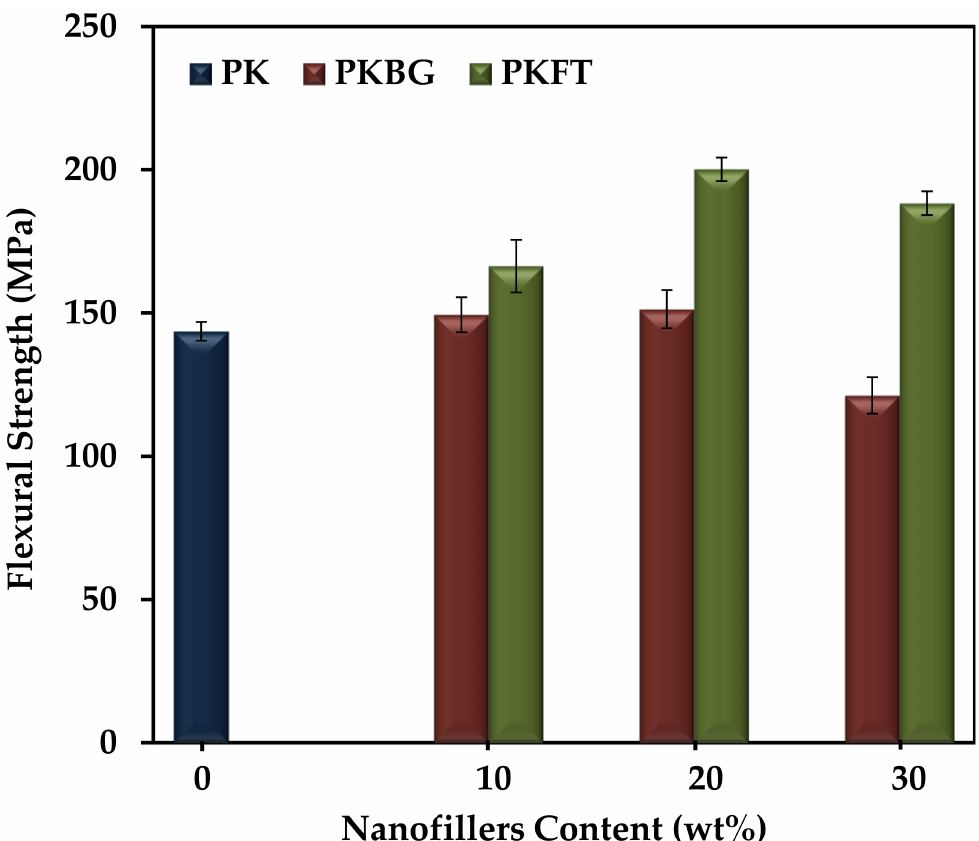
Figure 4. Variations of elastic compression elastic modulus (mean ± SD) of the PEEK-based nanocom- posites as a function of BG and FT content. ( n = 6, p <